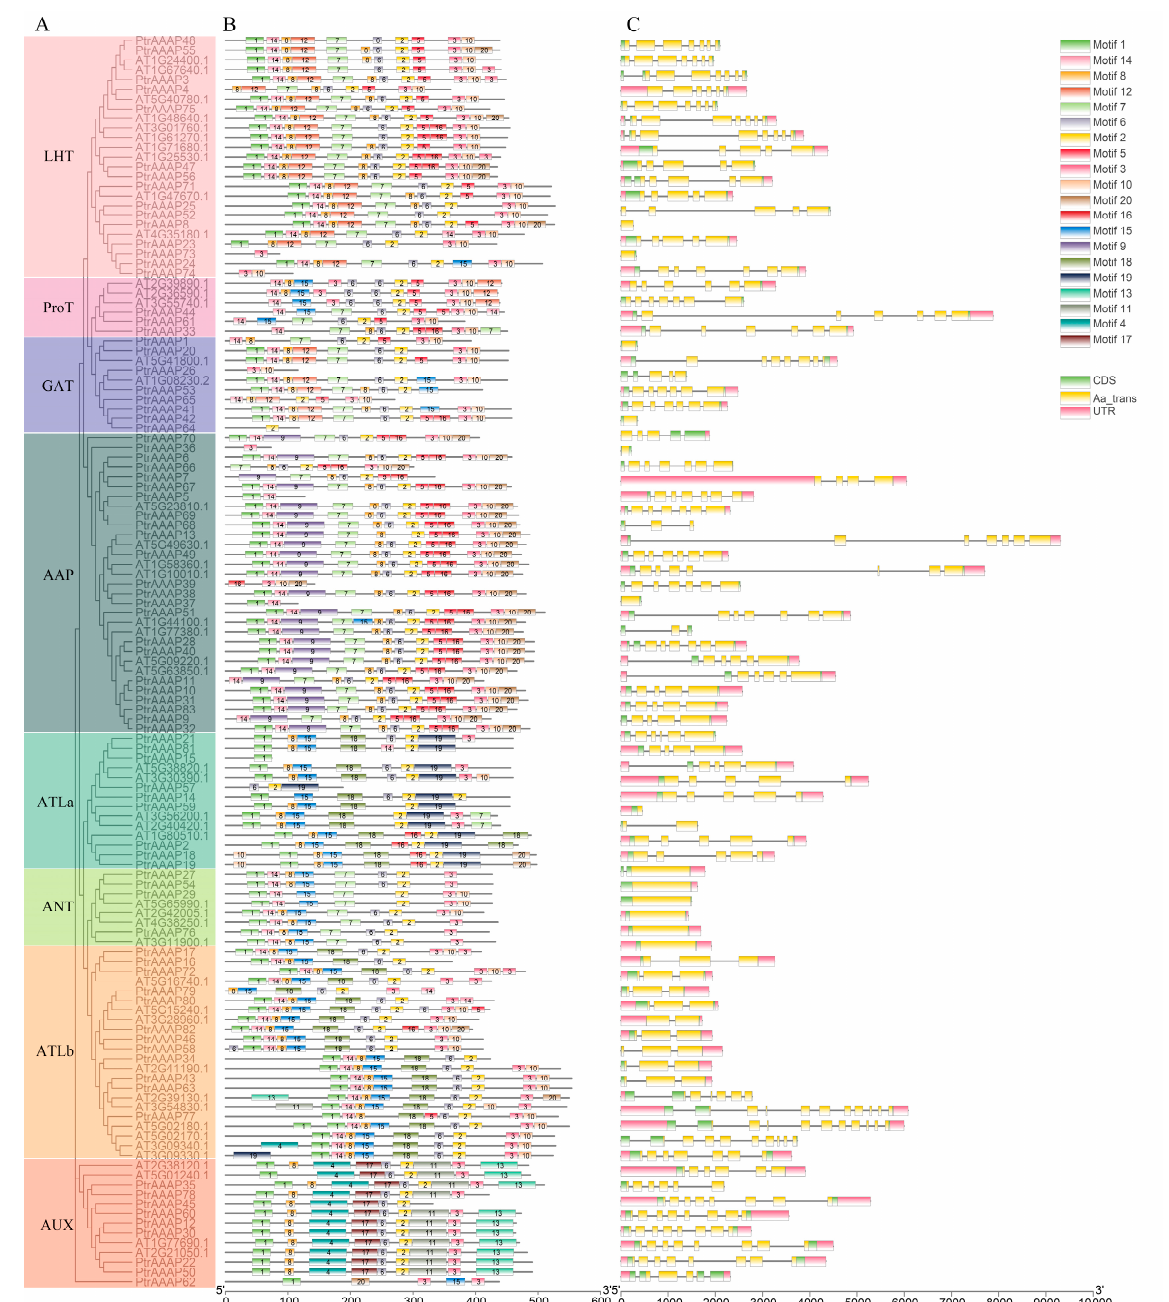
Figure 4. Phylogenetic and genetic structure analysis of PtrAAAPs . ( A ) Phylogenetic tree constructed using the maximum likelihood method and 83 PtrAAAPs protein sequences were divided into 8 subfamilies. ( B ) Distribution of motifs in PtrAAAP proteins, 20 motifs in total. ( C ) Structure of the PtrAAAPs , with the UTR in pink, the exon in green, the intron in the middle of the blank region, and the Aa_trans domain in yellow.